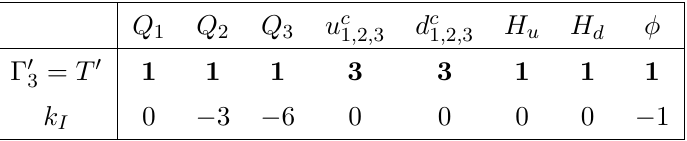
Table 3. The representation of the quark and the Higgs